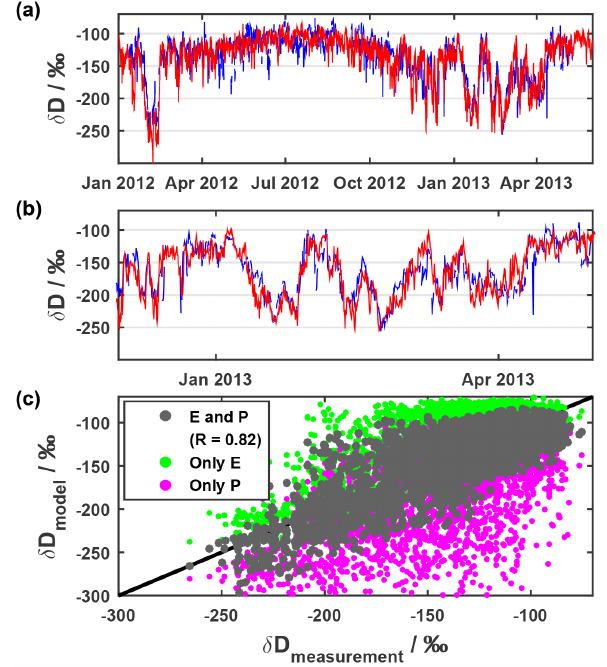
Figure 7. (a) Time series of measured (blue) and modeled (red) δ D of water vapor in Karlsruhe. (b) Enlarged section of (a) , which demonstrates the capability of the model of capturing the high vari- ability of δ D in winter. (c) Measured versus modeled δ D. The 3- hourly available modeled δ D is compared to the temporally closest 10min average of the δ D observations. Gray: reference run, surface evaporation ( E ), and the formation of precipitation ( P ) are consid- ered ( R = 0 . 82, (cid:49)δ D = − 4 . 1‰); green: only E is considered and P is ignored ( R = 0 . 79, (cid:49)δ D = + 23 . 9‰); magenta: only P is con- sidered and E is ignored ( R = 0 . 62, (cid:49)δ D = − 34 . 8‰); black: 1:1